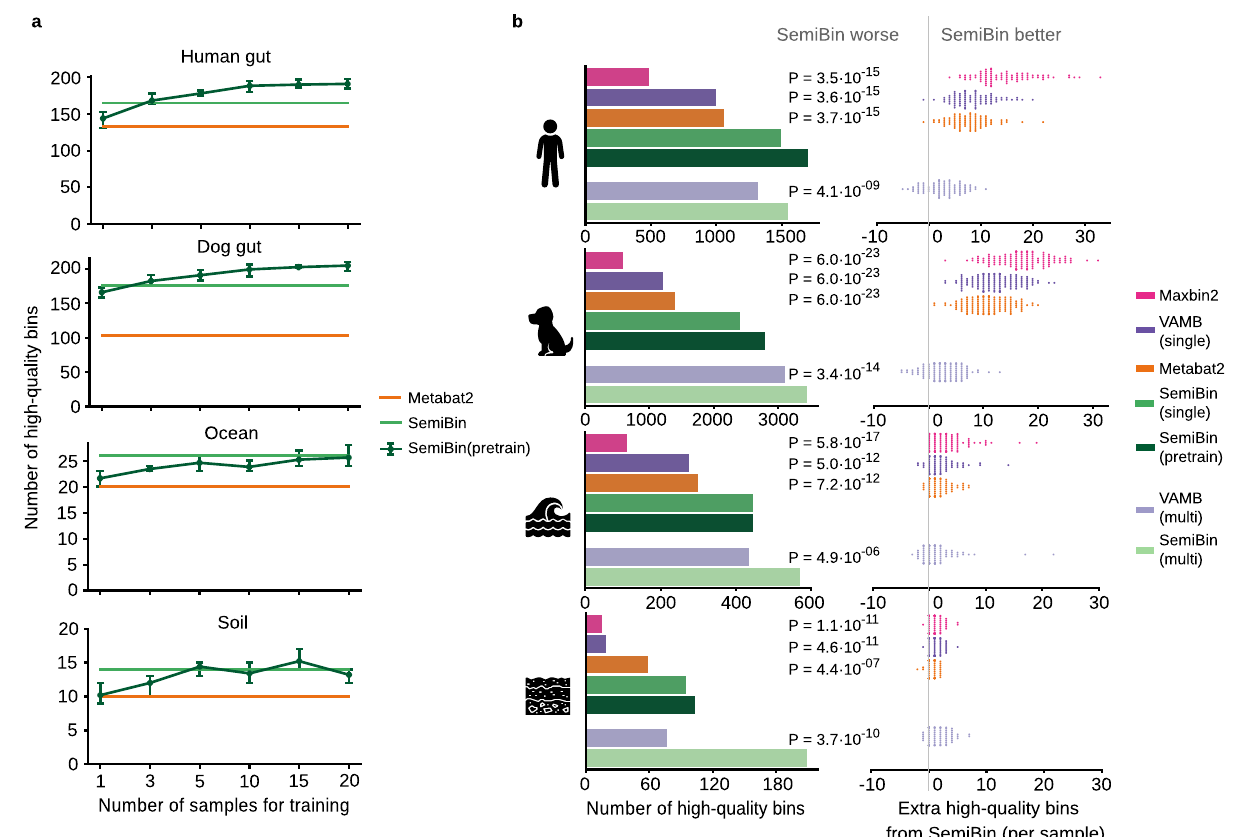
Fig. 3 SemiBin outperformed other binners in real datasets. a Number of high-quality bins (automatically evaluated using CheckM and GUNC, see Methods) using a pretrained model with different numbers of samples (per-sample SemiBin and Metabat2 shown for comparison). Data are presented as mean and range (the maximum datapoint minus the minimum) from the fi ve runs. b SemiBin(pretrain) produced more high-quality bins compared to Maxbin2, VAMB and Metabat2 in the human gut ( n = 82 samples), dog gut ( n = 129 samples), ocean ( n = 109 samples) and soil ( n = 101 samples) data sets (left). When considering the results in each sample (right), SemiBin(pretrain) outperformed other single-sample binners in almost every sample. In the dog gut dataset, SemiBin(pretrain) always produced more high-quality bins than any other per-sample method. In the human gut, ocean, and soil data sets, other methods occasionally outperformed SemiBin(pretrain) (observed for two human gut samples, nine ocean samples, and fi ve soil samples), but the difference is never large (at most, two extra high-quality bins were produced). Results of VAMB in multi-sample binning mode are compared to SemiBin(multi), with SemiBin(multi) producing more high-quality bins overall (although not in every sample). P-values shown are from a Wilcoxon signed- rank test (two-sided) on the counts for each sample. Source data are provided as a Source Data fi